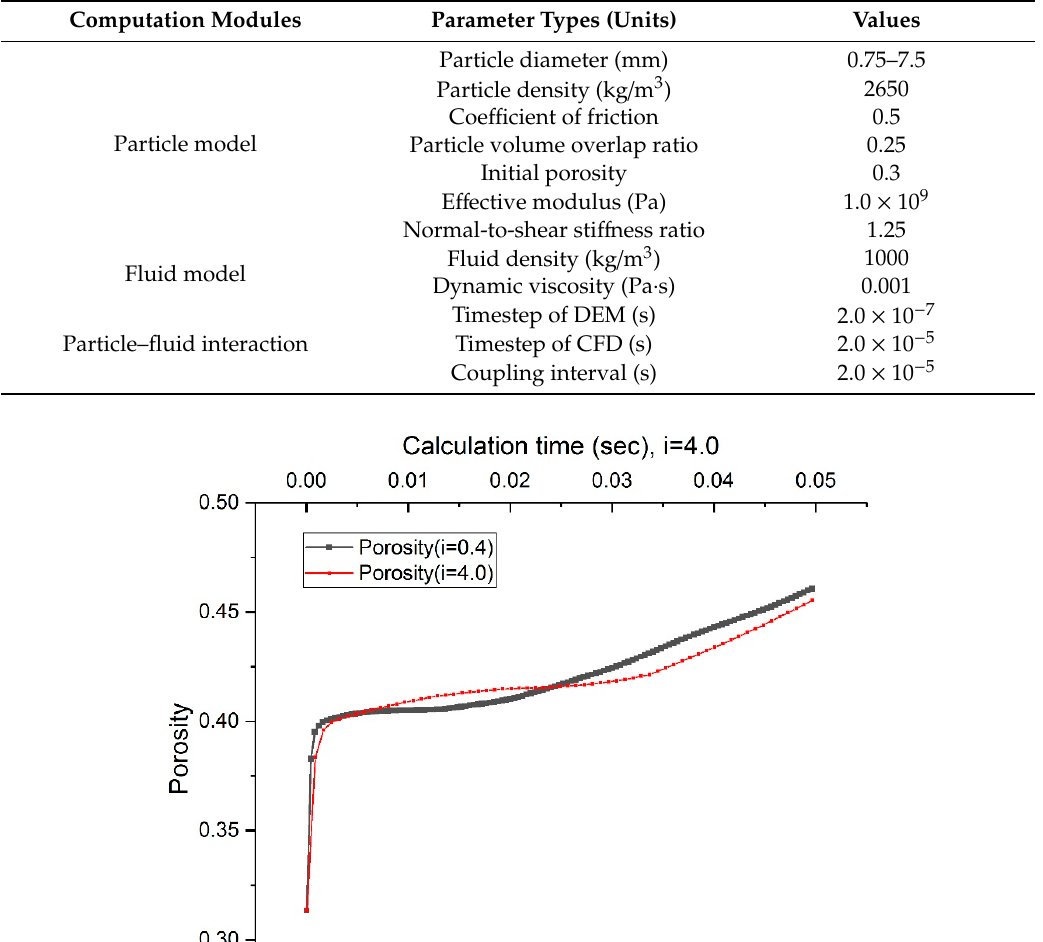
Table 1. Model parameter details.